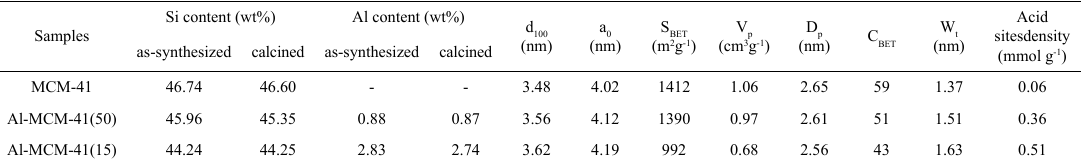
Table 2. Physicochemical properties of the calcined solids.